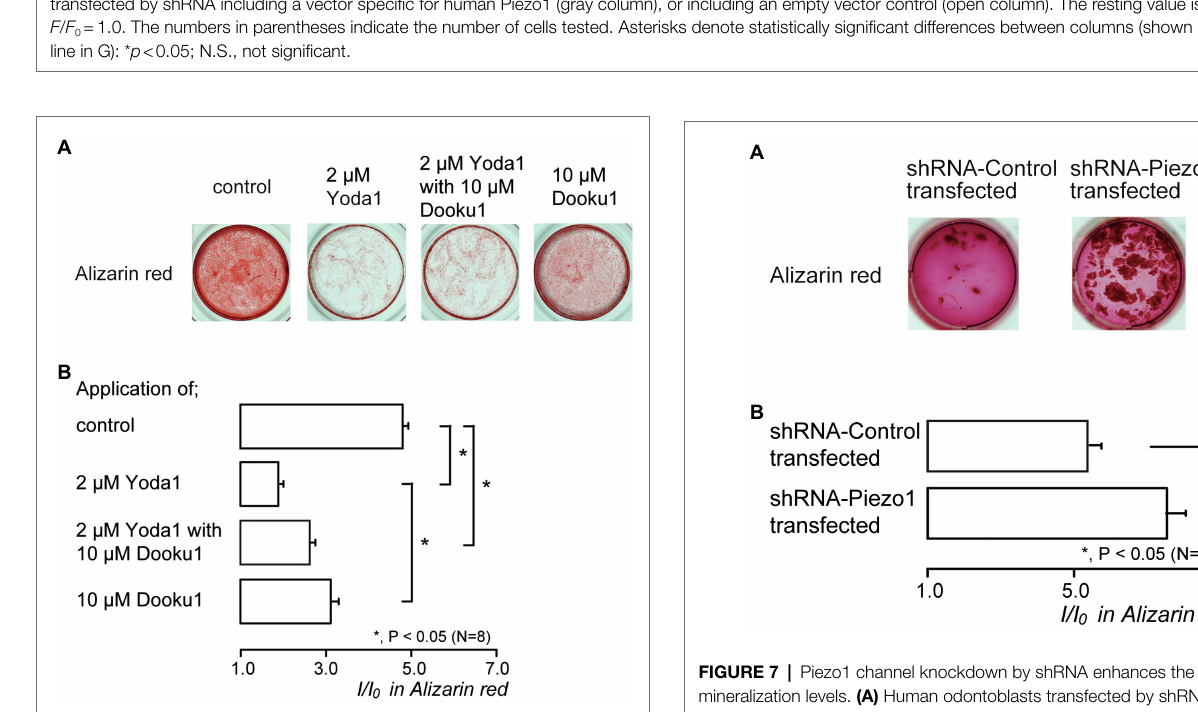
FIGURE 6 | Piezo1 channel activation decreases the mineralization levels. (A) Human odontoblasts were cultured for 28 days in mineralization medium with 2 μ M Yoda1 (second left), 2 μ M Yoda1 and 10 μ M Dooku1 (third left), 10 μ M Dooku1 (right most), or without these channel modifiers (left most) at pH 7.4, and stained by Alizarin red (red, calcium deposition). (B) Mineralization levels without (control; upper most column) or with 2 μ M Yoda1 (second column), 2 μ M Yoda1 and 10 μ M Dooku1 (third column), and 10 μ M Dooku1 (lower column), assessed by Alizarin red staining. The mineralization levels were 4.80 ± 0.13 I / I 0 in the absence of Piezo1 channel modifiers (as controls), while those 1.96 ± 0.04 I / I 0 with 2 μ M Yoda1, 2.63 ± 0.12 I / I 0 with 2 μ M Yoda1 and 10 μ M Dooku1, and 3.11 ± 0.18 I / I 0 with 10 μ M Dooku1. Each column denotes the mean ± SE from eight experiments. Statistically significant differences between columns (shown by solid lines) are indicated by asterisks. * p < 0.05.